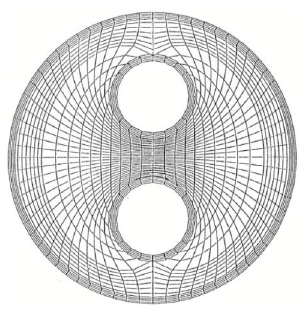
Figure 2. The typical composite overlapping grid system used in this study. [13]